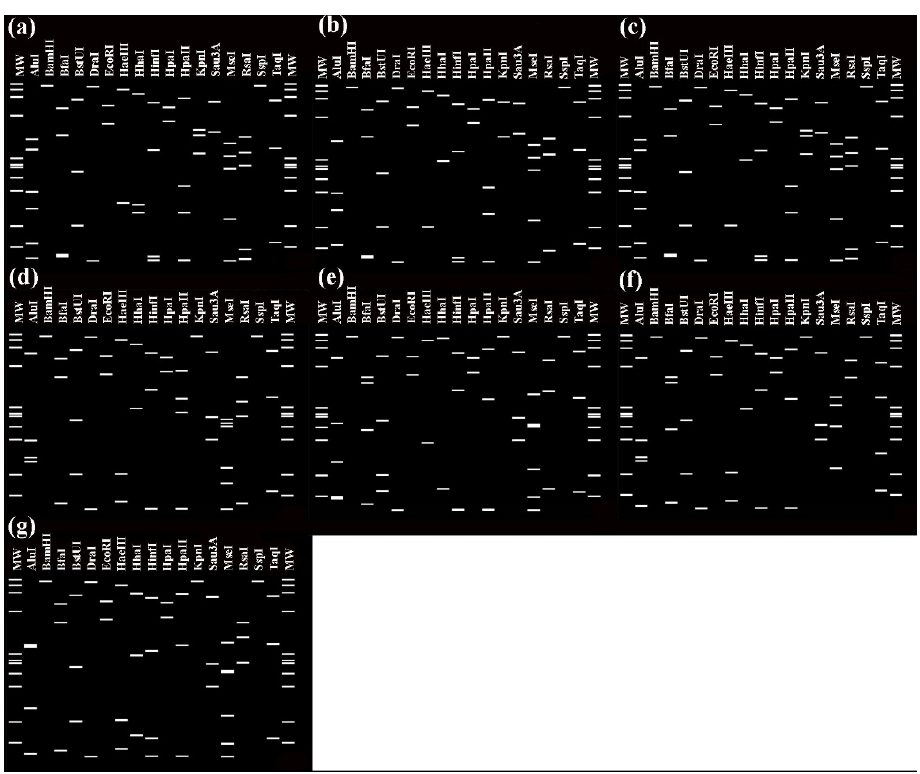
Figure 1. Distinct virtual RFLP patterns from in silico digestion of 16Sr gene F2nR2 fragments of the